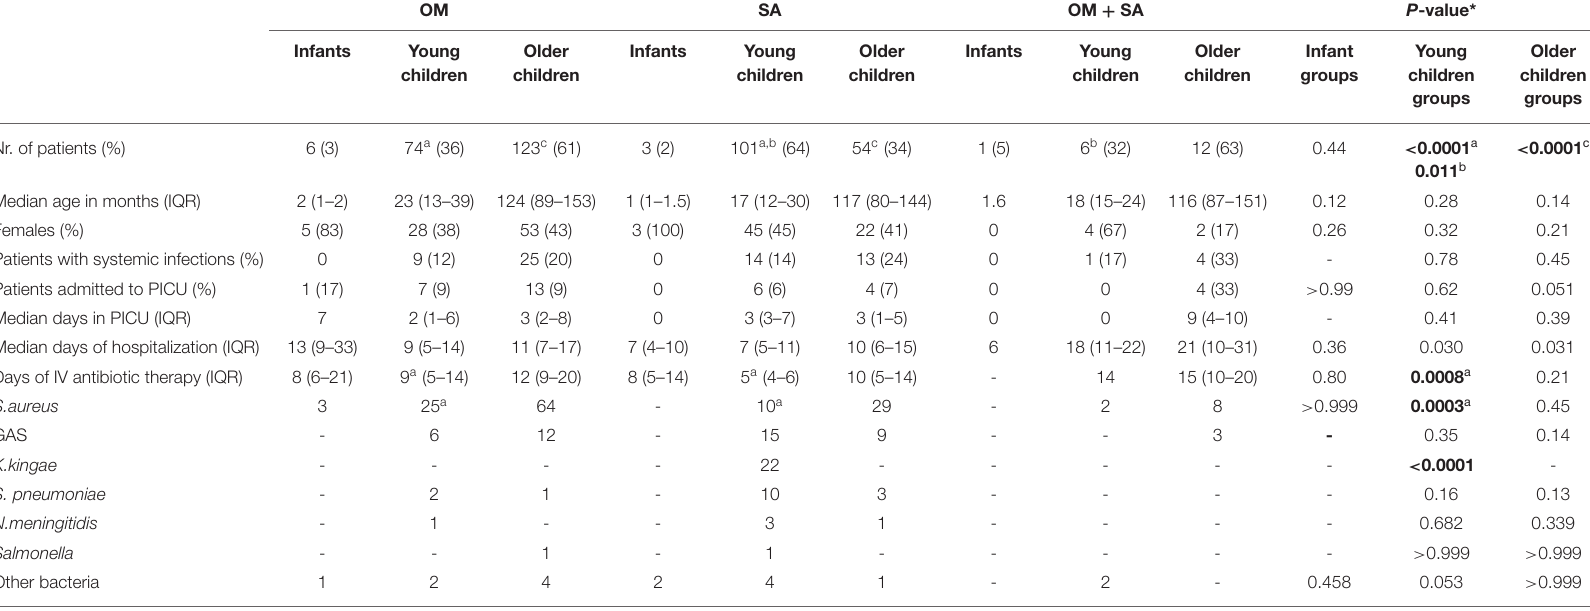
TABLE 2 | Characteristics of patients with bone and joint infections subgrouped according to age into infants ( ≤ 3 months), young children ( > 3–60 months), older children ( > 60 months). OM SA OM +